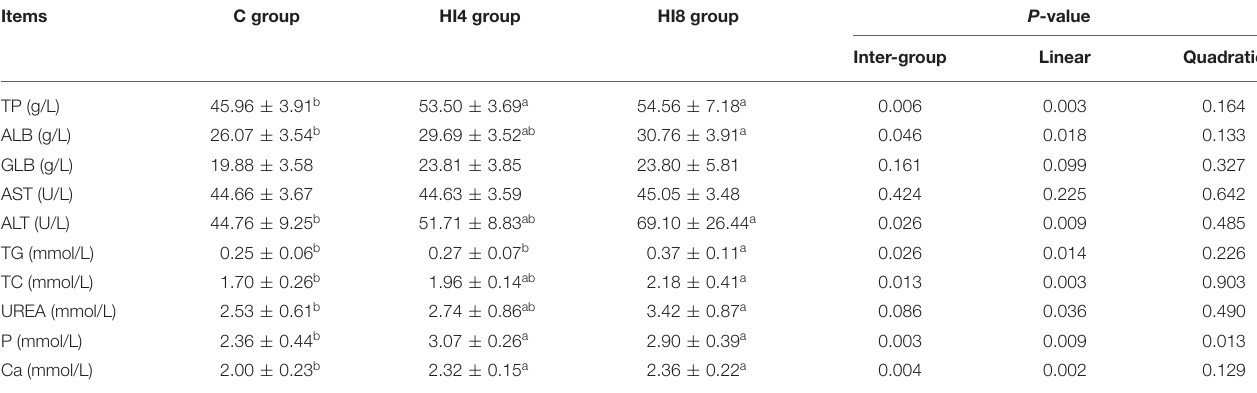
TABLE 5 | Effects of Hermetia illucens larvae on serum biochemical parameters of weaned piglets ( n = 8).